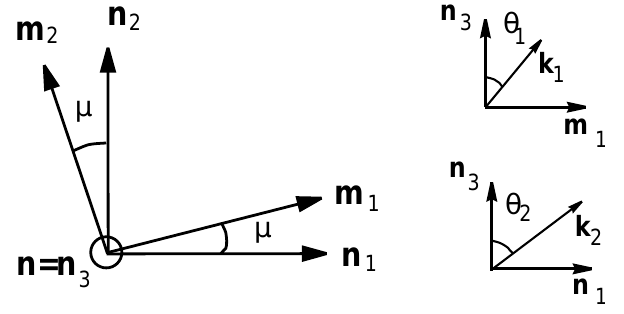
Fig. 2. Definition of the parameters governing the polarization co- efficients of the incident and reflected plane waves: the plane of the two-dimensional antenna used for signal registration contains the unit vectors n 1 , n 2 , m 1 , and m 2 ( ( n 1 ,n 2 ) = ( m 1 ,m 2 ) = 0 , ( n 1 ,m 1 ) = cos µ ), and its oriented normal n ≡ n 3 is parallel to the ambient magnetic field B 0 ; the wave vectors k 1 and k 2 of the incident and reflected waves are situated in the planes formed by the unit vectors n 3 , m 1 and n 3 , n 1 , respectively, with ( k 1 , n 3 ) = k 1 cos θ 1 and ( k 2 , n 3 ) = k 2 cos θ 2 ; µ represents the angle between these